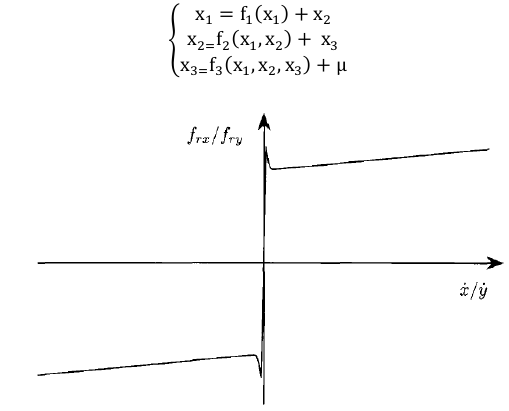
Figure 3: Friction relationship with the vehicle